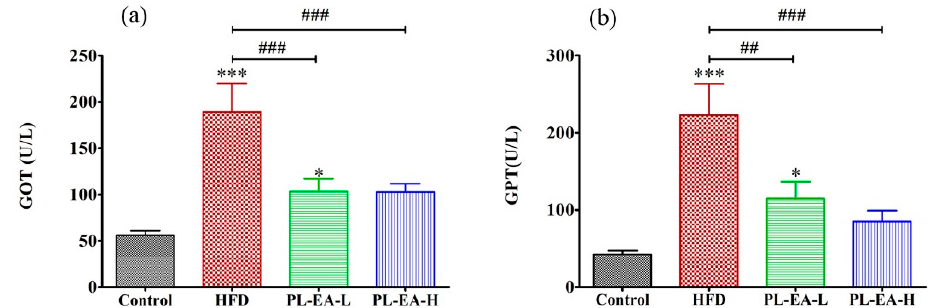
Figure 5. Effects of ethyl acetate fraction from P. linteus mycelia on the activities of ( a ) plasma aspartate aminotransferase and ( b ) plasma alanine aminotransferase. HFD: high-fat/high-fructose diet (HFD). PL-EA-L: HDF + low dose PL-EA (35 mg/kg). PL-EA-H: HDF + high dose PL-EA (70 mg/kg). Data are expressed as mean ± SE ( n = 9). ## p <0.01; ### p < 0.001 vs. the HFD group; * p < 0.05; *** p < 0.001 vs. the control.